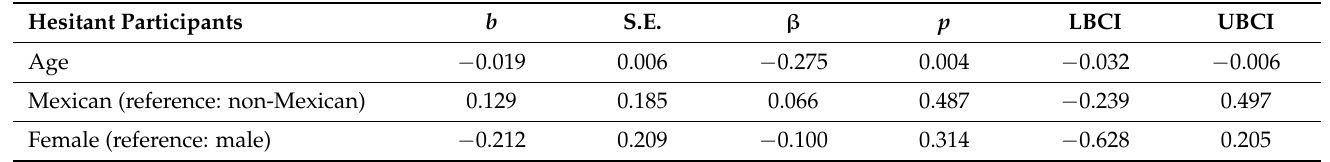
Table 6. Multiple regression models for the sustenance of COVID-19 vaccination among hesitant and non-hesitant